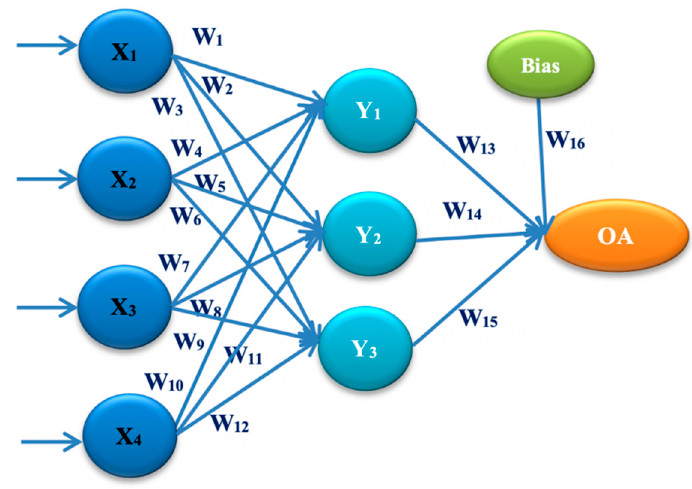
Figure 2. ANN architecture with one hidden layer (ANN-L36prim). Table 2. Taguchi Orthogonal Array (L36prim = 3 11 2 4 3 1 ).